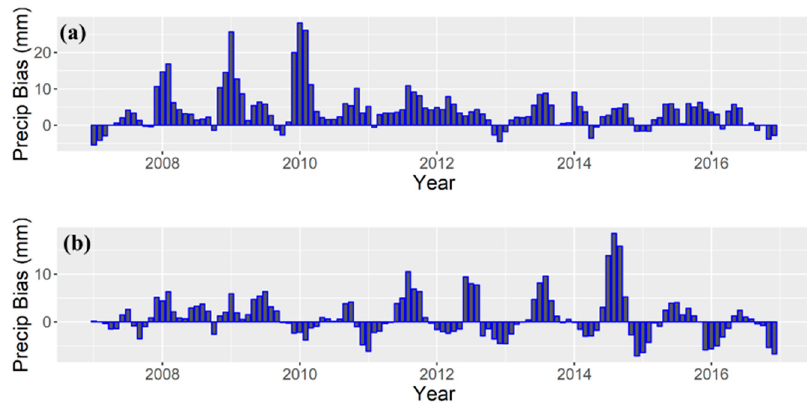
Figure 6. WRF-SSIB-SIMGM monthly precipitation bias for ( a ) the Coastal Basin aquifer and ( b ) the Basin and Range aquifer systems compared to North American Regional Reanalysis (NARR) data.